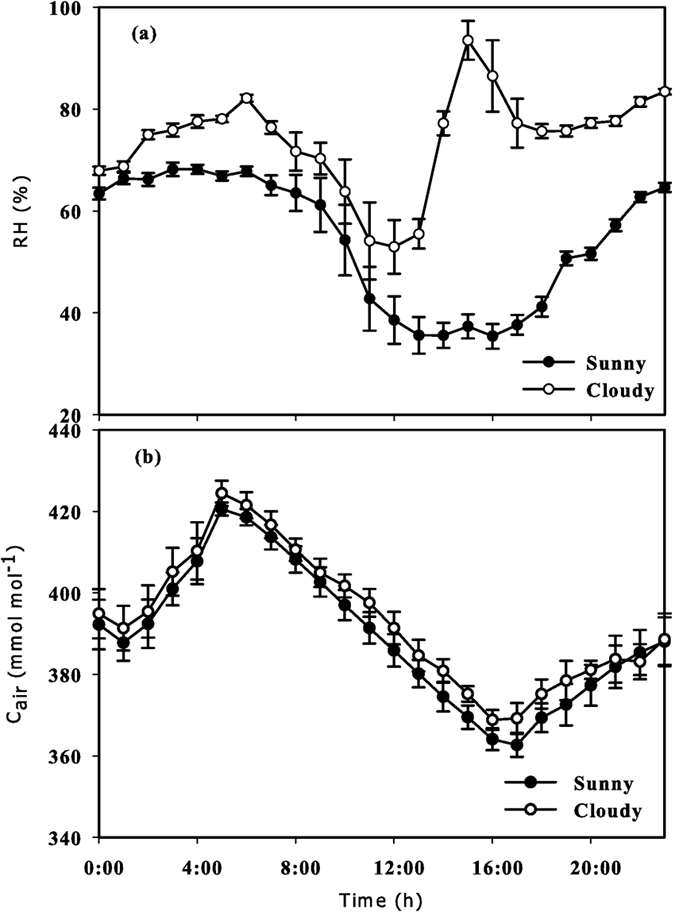
The hourly average air relative humidity (RH, a) and CO2 concentrations (Cair, b) of the crowns under sunny (●) and cloudy (○) conditions in summer. All values are means ± SE; n = 36 (a) and 120 (b).